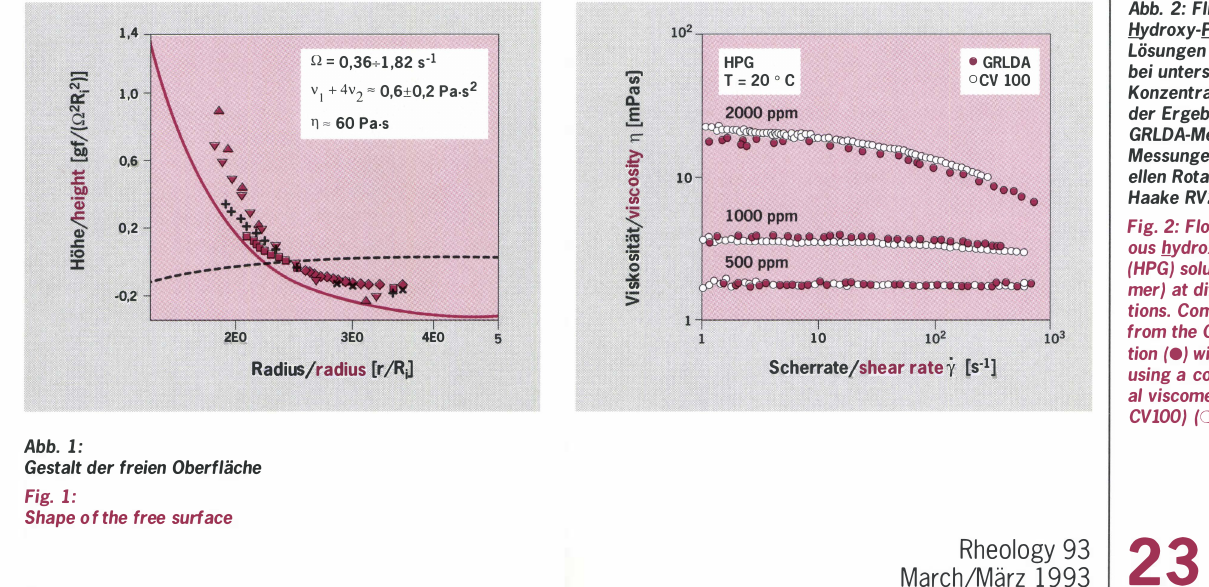
Fig. 1: Shape of the free surface